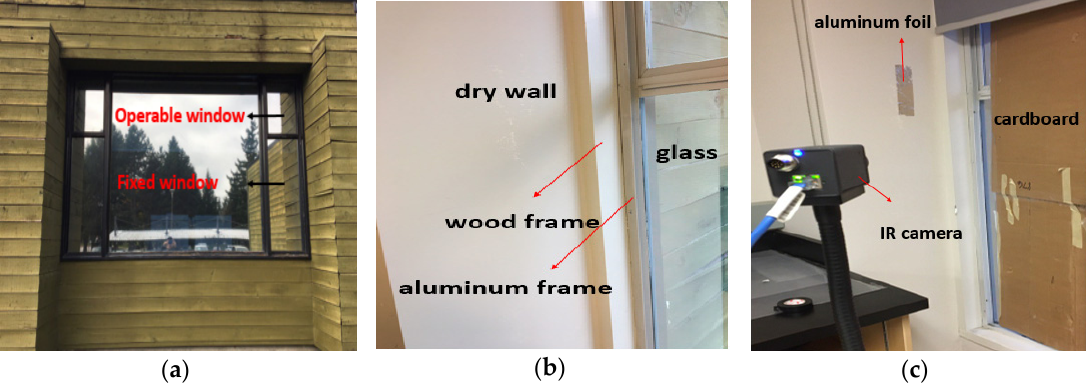
Figure 1. Test area viewed from ( a ) the exterior; ( b ) the interior, showing the window frames; and ( c ) the camera position. the camera